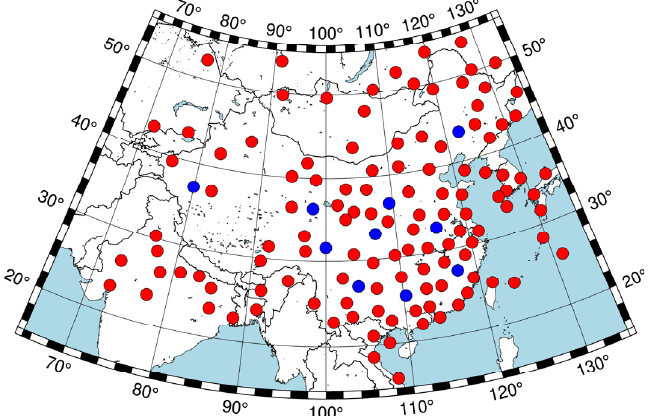
Figure 3. Distribution of radiosonde stations in China. The dots denote the positions of the sta ‐ tions.